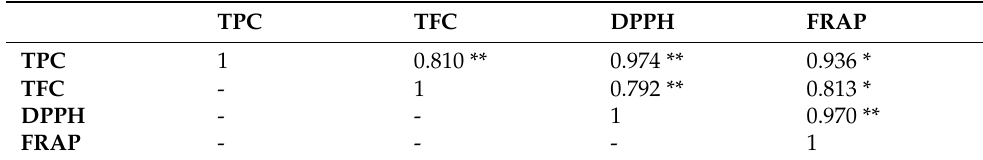
Table 6. Correlations between total phenolic content, total flavonoid content, DPPH scavenging and FRAP activities of mulberry fruits with ripening. TPC TFC DPPH FRAP TPC 1 0.810 ** 0.974 ** 0.936 * TFC - 1 0.792 ** 0.813 * DPPH - - 1 0.970 ** FRAP -